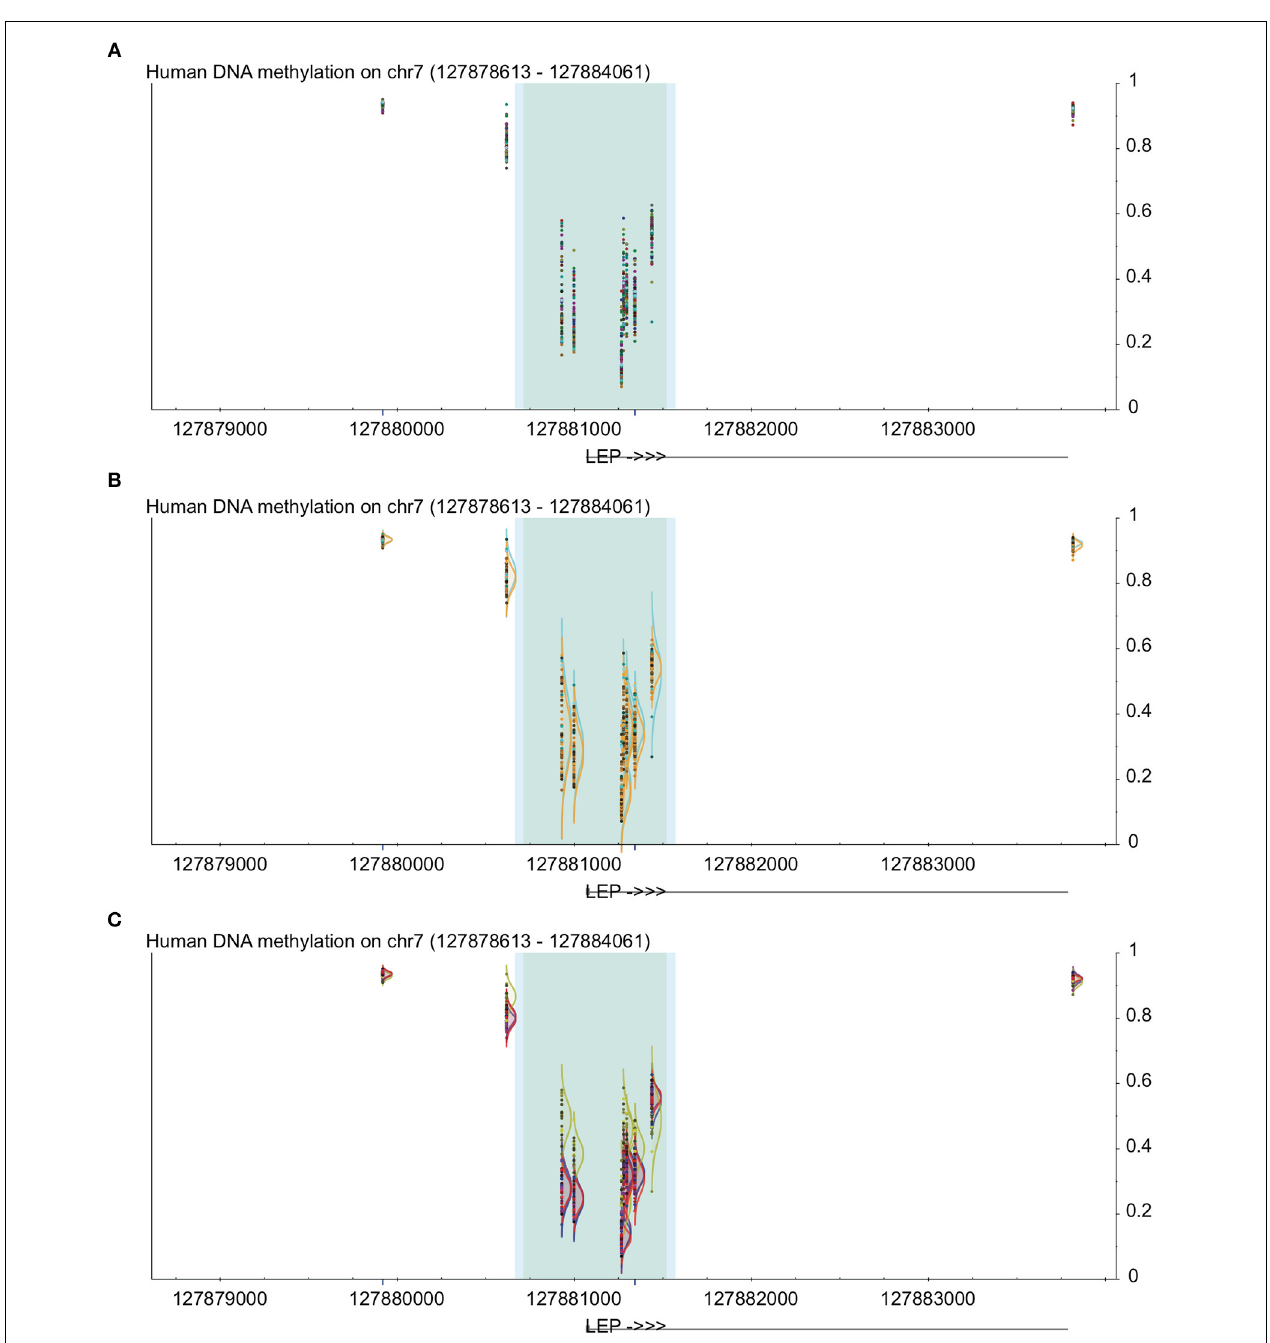
FIGURE 1 | Example of uses of visualization methods in DaVIE using LEP gene as an example. All panels show DNA methylation from 0 to 1 on the y-axis at the LEP promoter, including high-density CpG islands (dark gray) and intermediate density islands (light blue), with gene structure indicated below.